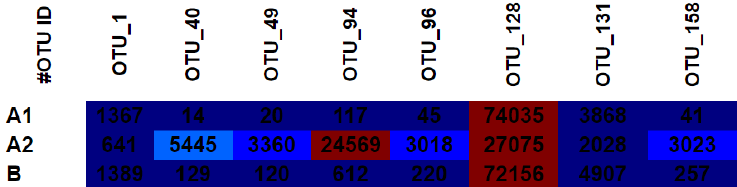
Figure 7. OTU heat map. Blue color represents a low percentage of OTUs; red color represents a high percentage of OTUs to sample (filter by counts per OTU: 2000).